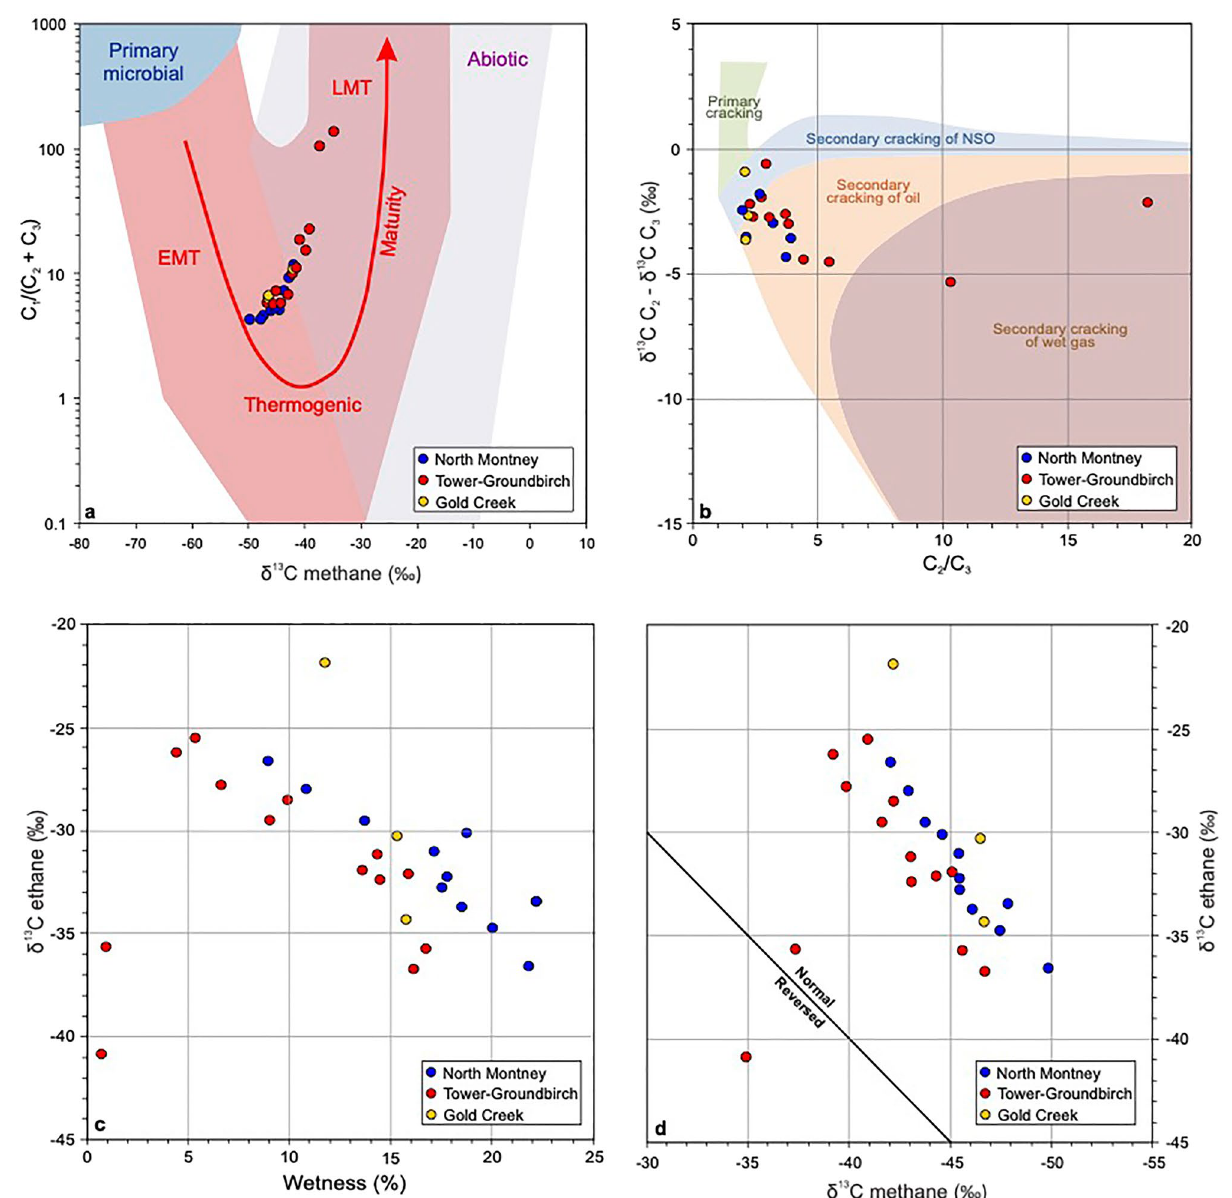
Figure 3. Compositional and isotopic plots for Montney produced gas samples. ( a ) δ 13 C methane vs. C 1 / (C 2 + C 3 ) Bernard plot 48 . Gas genetic fields and maturity trend (red arrow) from Milkov and Etiope 49 : EMT early mature thermogenic gas, LMT late mature thermogenic gas. ( b ) C 2 /C 3 vs. δ 13 C ethane—δ 13 C propane Lorant plot 50 . NSO signifies petroleum fluid rich in polar nitrogen-, sulphur- and oxygen-containing organic compounds. ( c ) Gas wetness (Σ(C 2 –C 5 )/Σ(C 1 –C 5 )) vs. δ 13 C ethane cross-plot. ( d ) δ 13 C methane vs. δ 13 C ethane cross-plot. In panel ( a ), Montney produced gas samples from the three widely separated geographic areas (Fig. 1a) form a coherent maturity trend of oil-associated thermogenic gases. In panel ( b ), Montney produced gas samples lie in fields expected for secondary cracking of oil and wet gas. In panels ( c , d ), the majority of the samples form a normal maturity trend, whereas two samples from the Groundbirch area indicate an ethane isotopic rollover/reversal zone 51,52